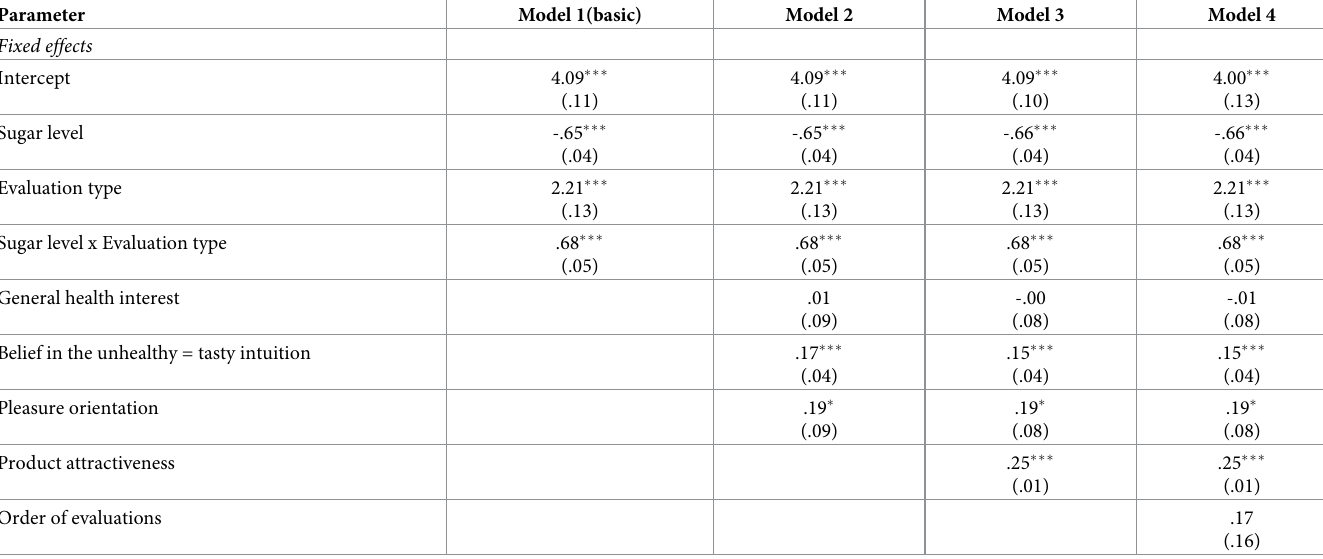
Table 2. Parameter estimates of the effects of sugar level and evaluation type on products evaluations, using LMM.